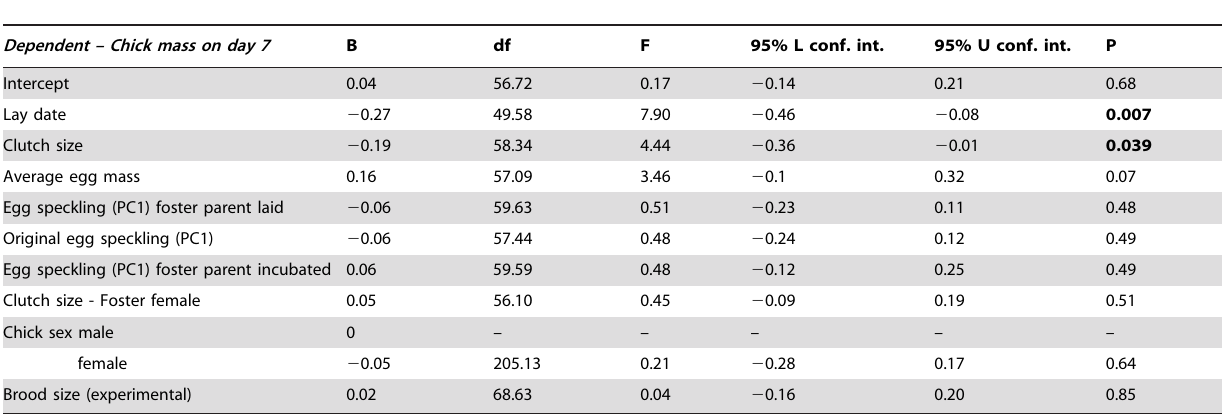
Table 3. DAY 7. Linear Mixed-effects Model showing no effect of egg speckling on chick mass on day